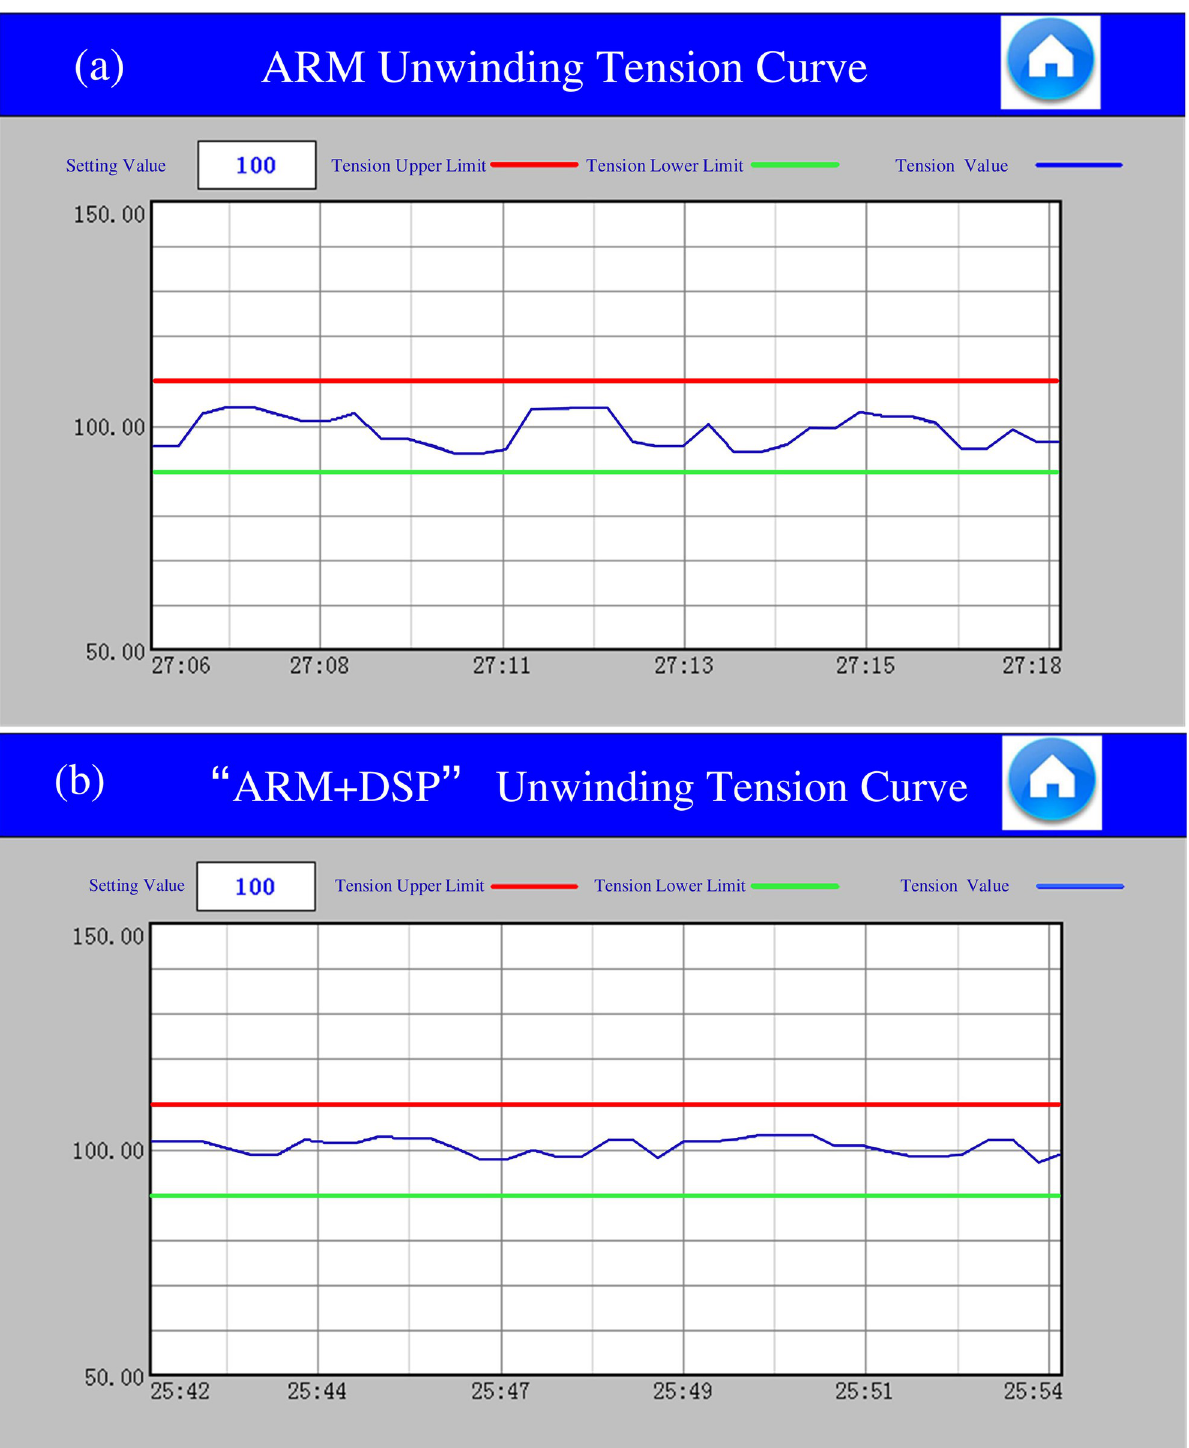
Fig 24. (a) ARM deflection control curve, (b) "ARM+DSP" deflection control curve.